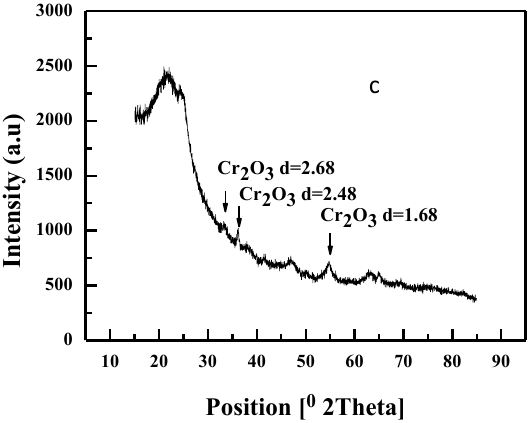
Figure 2. XPS patterns of ( a ) 2.9 wt% TiO 2 /SiO 2 -500; ( b ) 7.1 wt% Cr 2 O 3 -6.3 wt% NiO/SiO 2 -500; and ( c ) 1.4 wt% TiO 2 -6.1 wt% Cr 2 O 3 /SiO 2 -500.